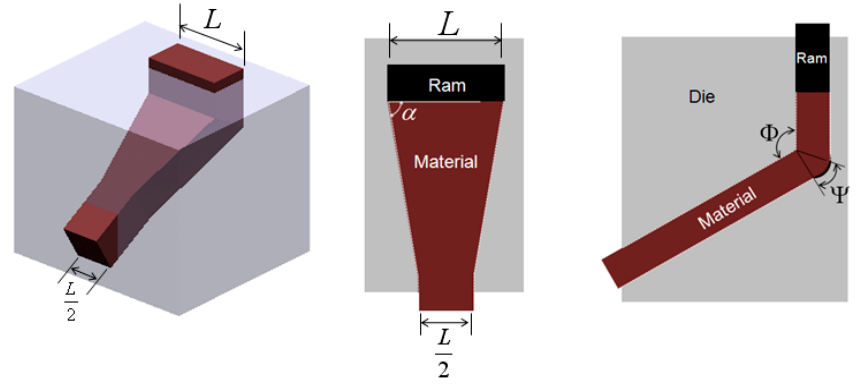
Figure 11. Schematic illustration of HCAE experiment design [38].